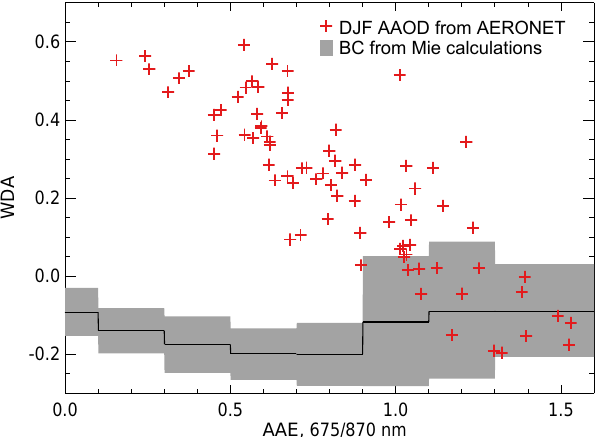
Figure 2. The range in the estimated wavelength dependence of AAE (WDA) for BC (shaded region) based on Mie calculations (see Sect. 2 for size and coating assumptions). The black line is the median WDA. Red crosses show the total absorption from 2005– 2014 10-year seasonal average AAOD measurements at three wave- lengths from the AERONET network in north hemisphere winter (December, January, and February). Observations which lie above the shaded region include detectable contributions of BrC absorp-